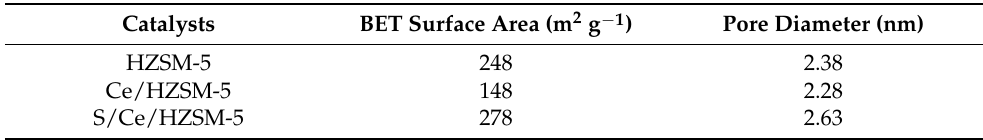
Figure 2. X-ray diffraction (XRD) patterns of the catalysts, (1) HZSM-5, (2) Ce/HZSM-5, and (3) S/Ce/HZSM-5. Table 1. Specific surface area, pore diameter for the catalysts.